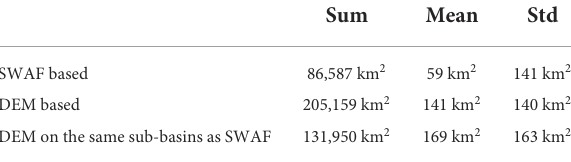
TABLE 1 Floodable areas for the different floodplain delineation methodologies (SWAF and DEM based) and the area estimated by the DEM based methodology on the sub-basins where SWAF data is